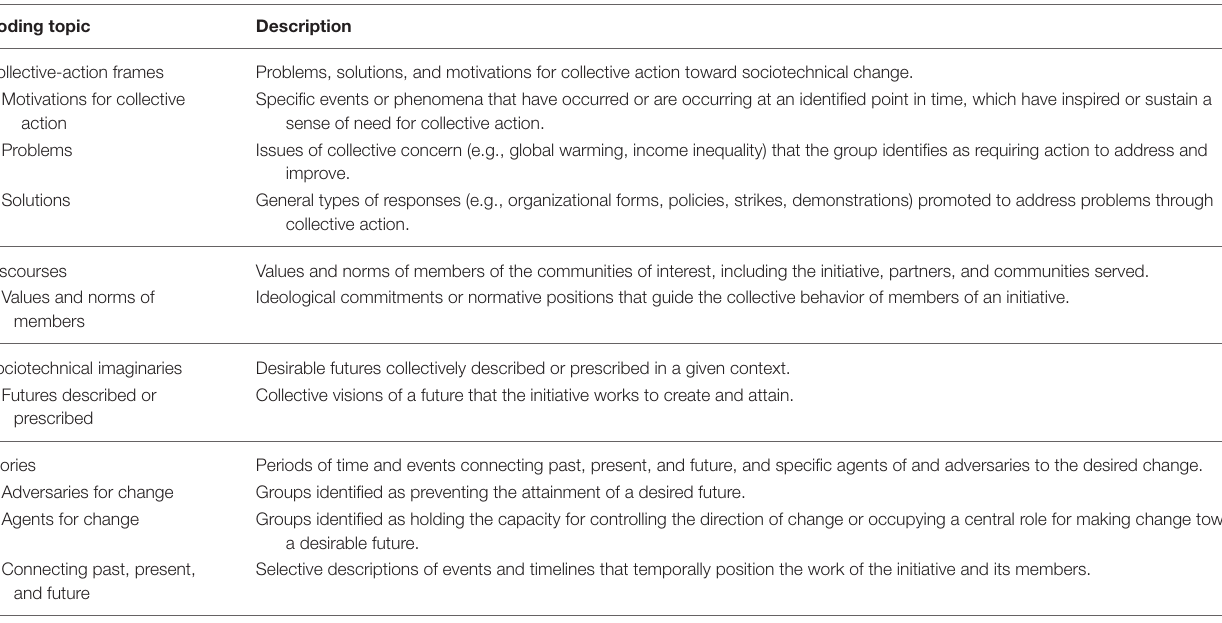
TABLE 1 | Coding topics and descriptions of elements of a transition narrative. Coding